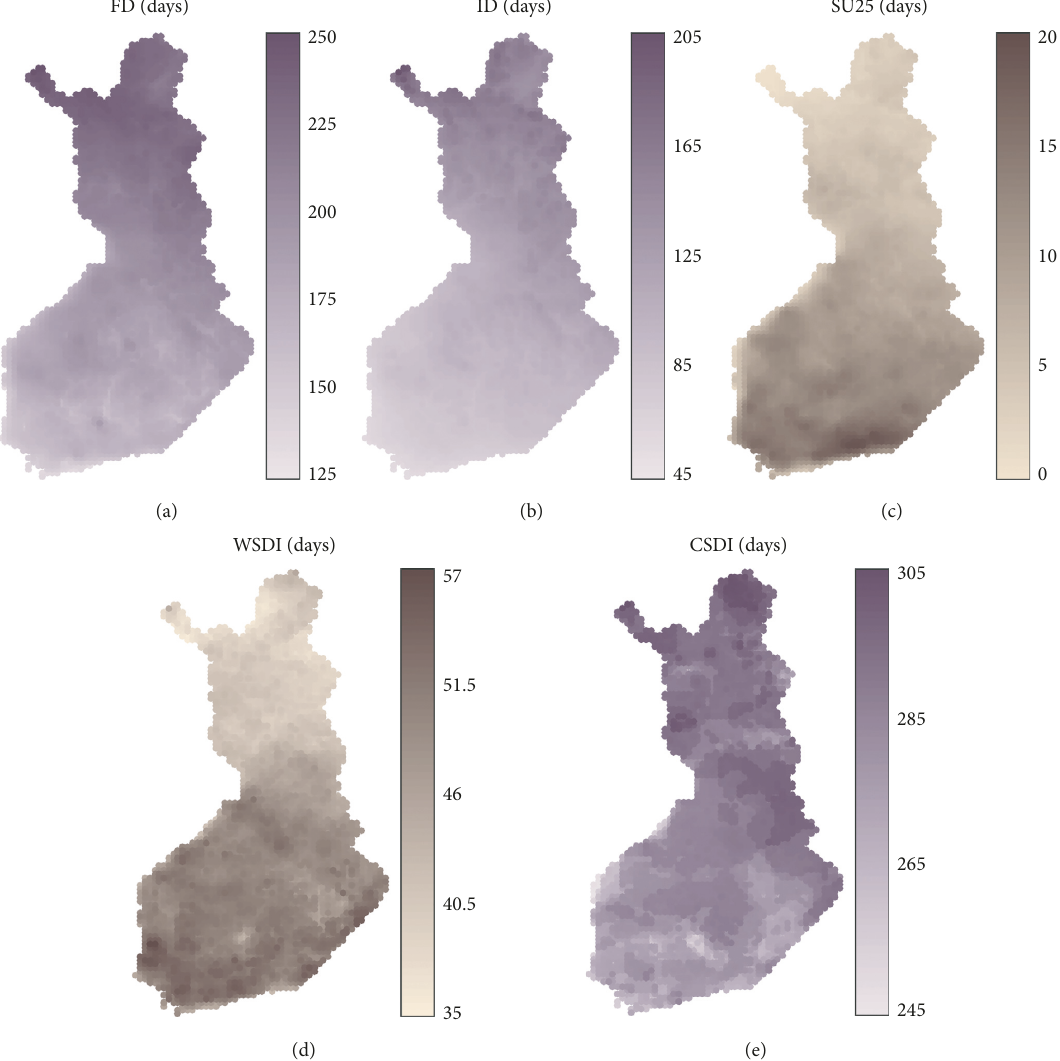
Figure 5: Spatial distribution maps of base values for (a) FD, (b) ID, (c) SU25, (d) WSDI, and (e) CSDI in Finland during